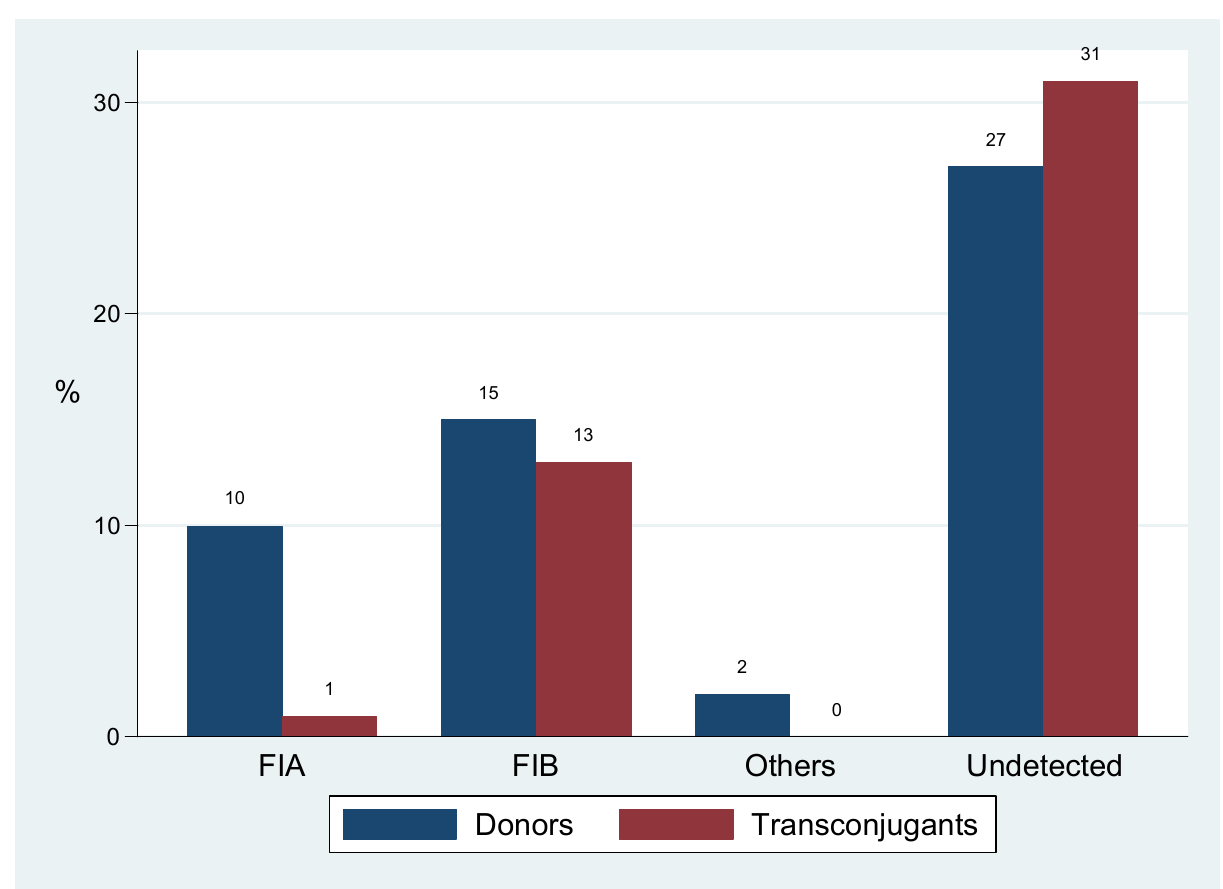
Figure 2. Replicon types of plasmids carrying bla CTX-M-15 among donors and transconjugants.